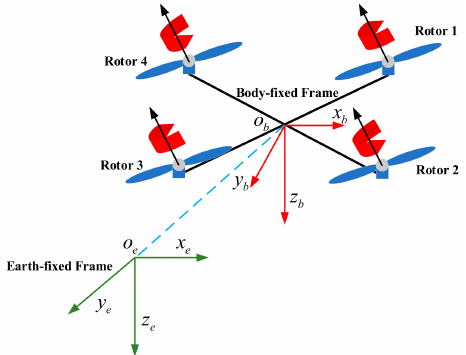
Figure 1. Basic configuration and reference frames used to model the quadrotor